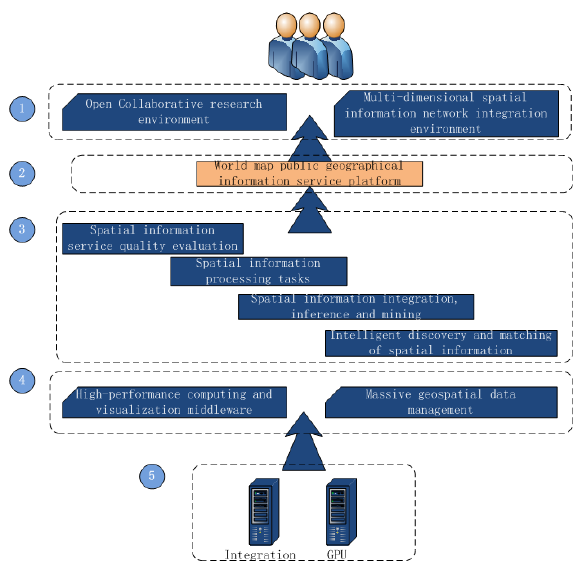
Figure 2 Web-based geospatial intelligence